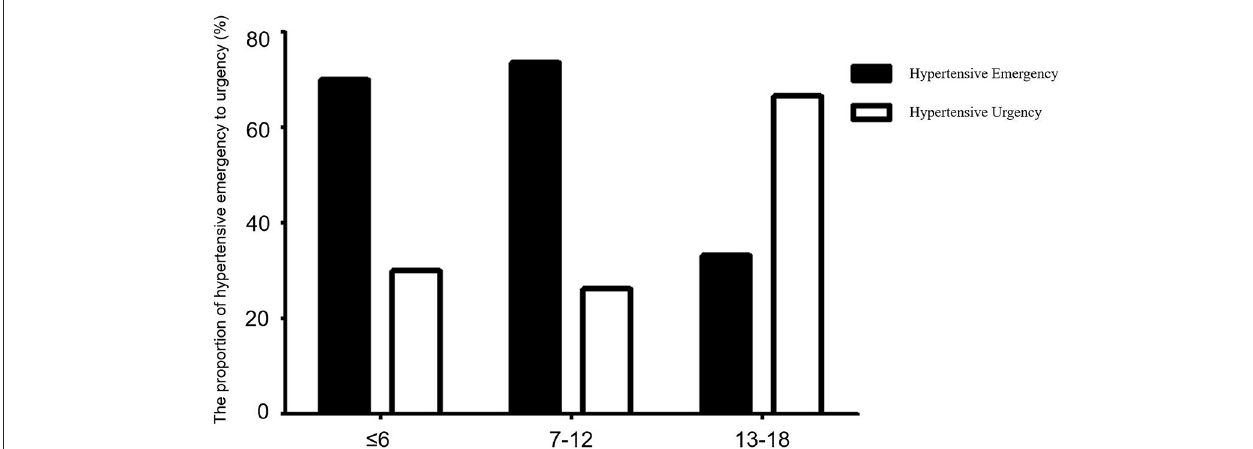
FIGURE 5 | Comparison of the proportions of hypertensive emergency and hypertensive urgency between different age groups. Solid and hollow columns represent hypertensive emergency and hypertensive urgency patients, respectively. There were 20 cases aged ≤ 6 years, of whom 14 (70.00%) were hypertensive emergency and 6 (30.00%) were hypertensive urgency. There were 38 patients aged 7–12 years, of whom 28 (73.68%) were hypertensive emergency, 10 (26.32%) were hypertensive urgency. There were 12 patients aged 13–18 years, of whom 4, (33.33%) were hypertensive emergency, 8 (66.67%) were hypertensive urgency. Hypertensive emergency was more common than hypertensive urgency among children aged 7–12 years ( χ 2 = 17.05, p < 0.001).